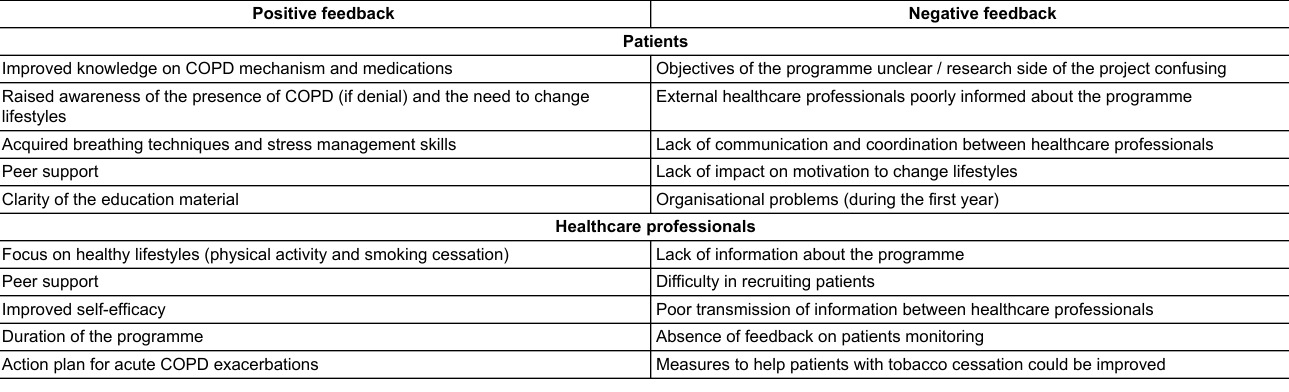
Table 2: Patients’ and healthcare professionals’ feedback on the